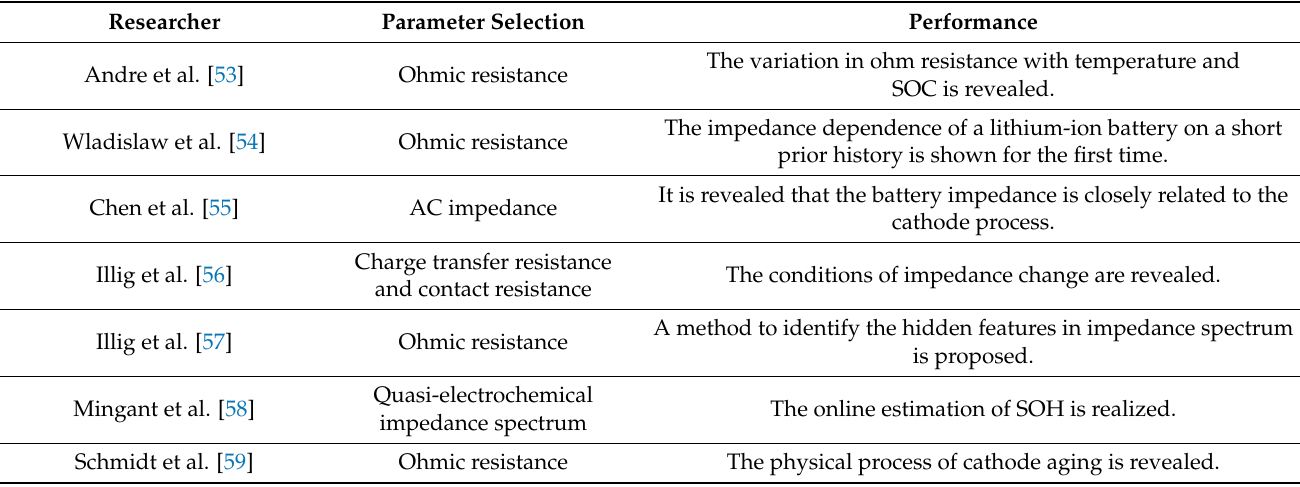
Table 2. Summary of methods for estimating SOH of LIBs based on equivalent circuit model